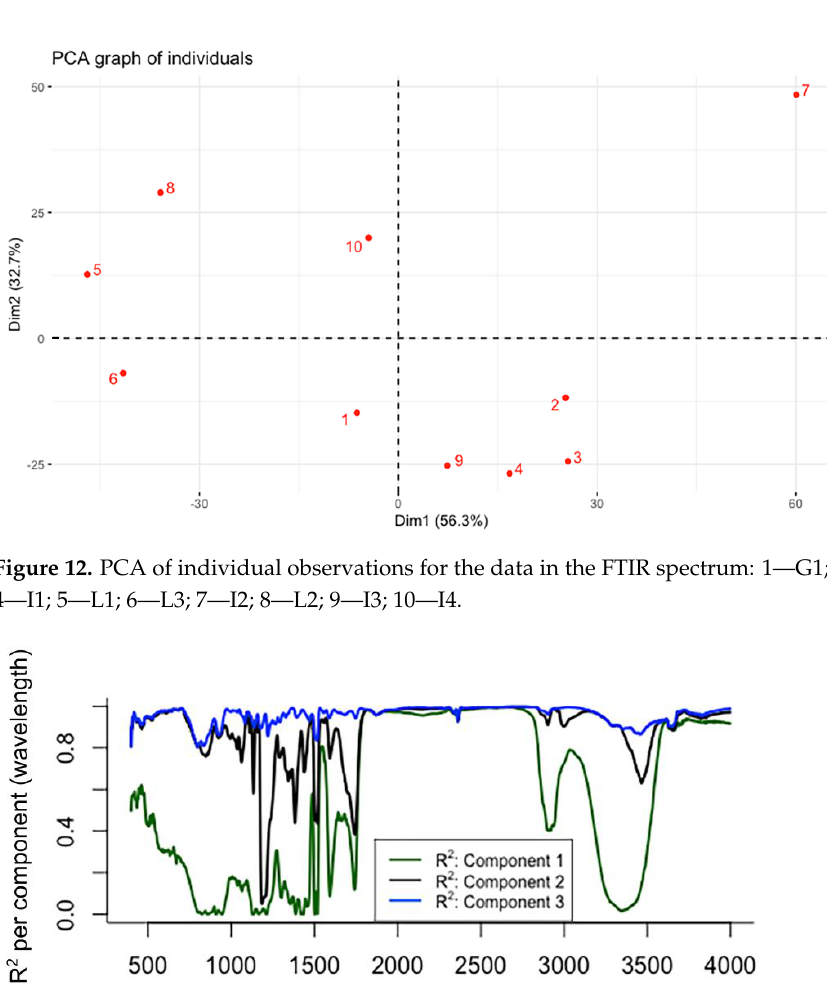
Figure 14. Cluster analysis by the k-means method (n = 4): 1—G1; 2—G2; 3—G3; 4—I1; 5—L1; 6— L3; 7—I2; 8—L2; 9—I3; 10—I4 .